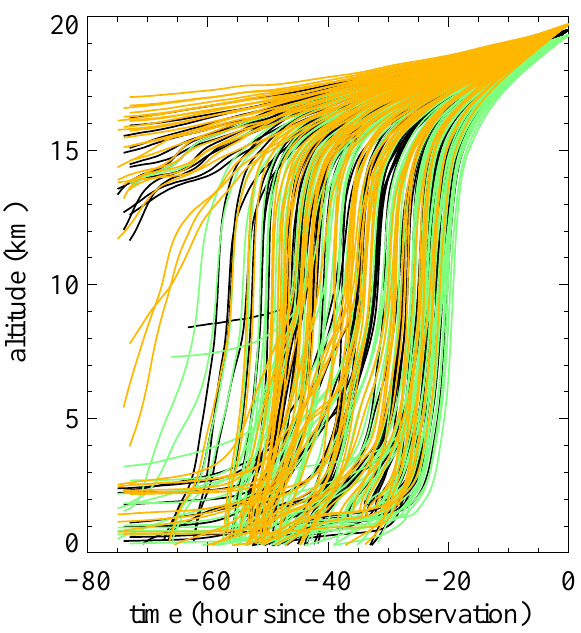
Fig. 6. Time-altitude plot of the 243 rays for which the initial condi- tions have been modified (green: rays which start at 19.3 km, black: 19.5 km, orange: 19.7